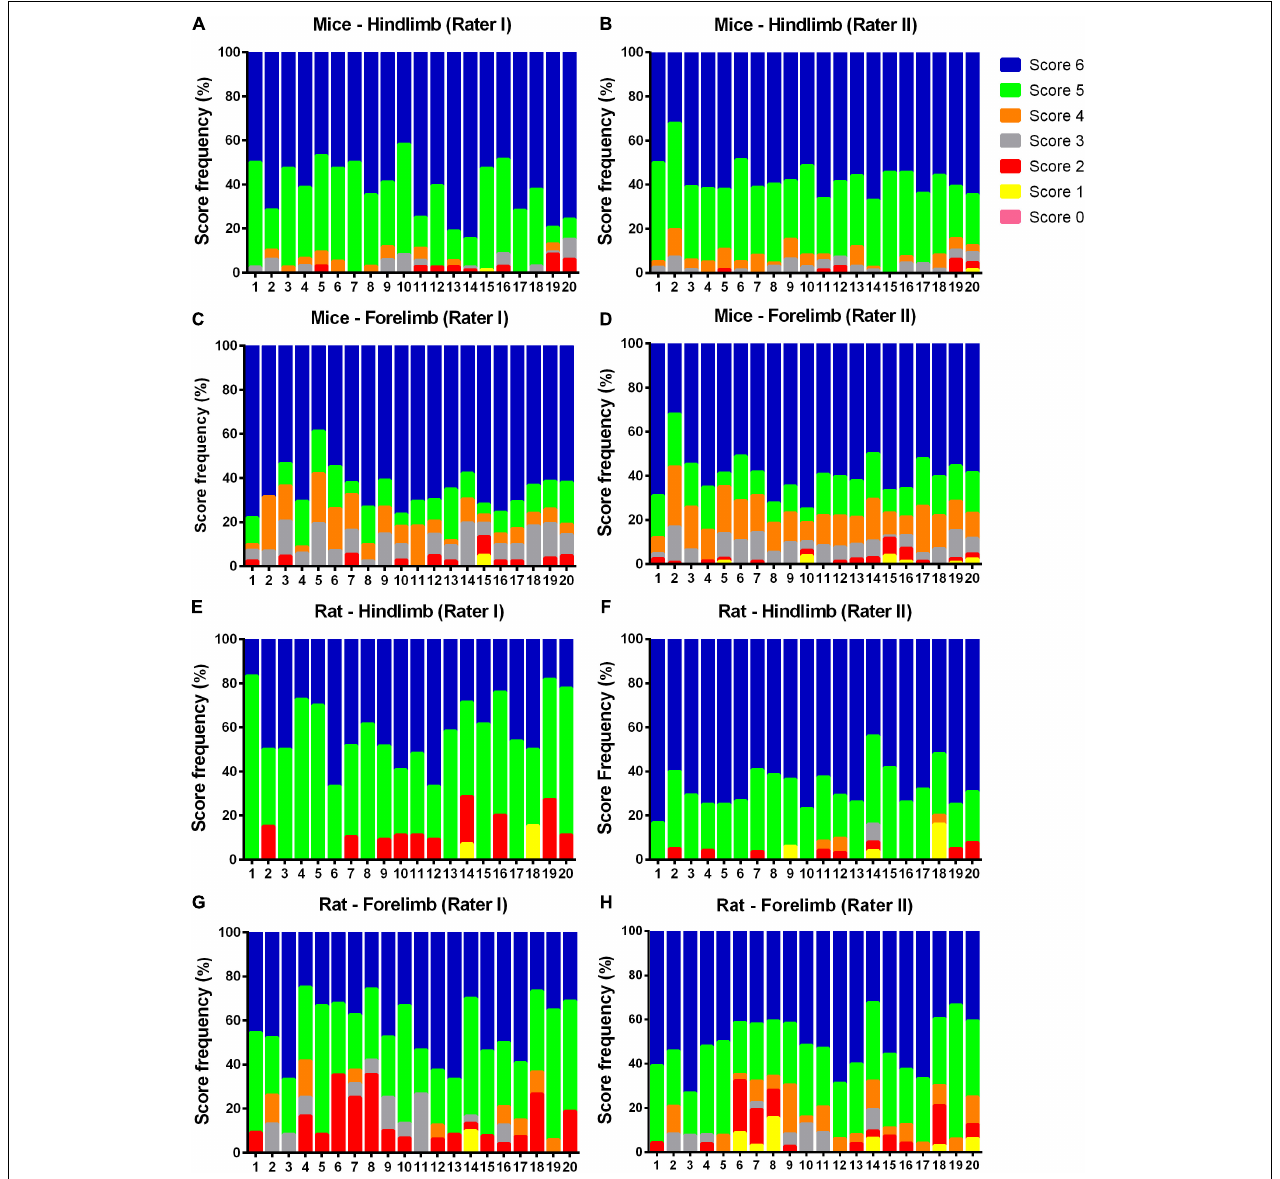
FIGURE 4 | Frequency (%) of each foot placement rate (from 0 to 6), as judged by raters I and II in the study rodents. Note that all possible foot placement rates were observed in the study sample, while score 6 (correct placement) was the most frequent for both forelimb and hindlimb, and the lower scores ( ≤ 3) were also present. (A–D) : mice hindlimb and forelimb rates; (E–H) : rat hindlimb and forelimb